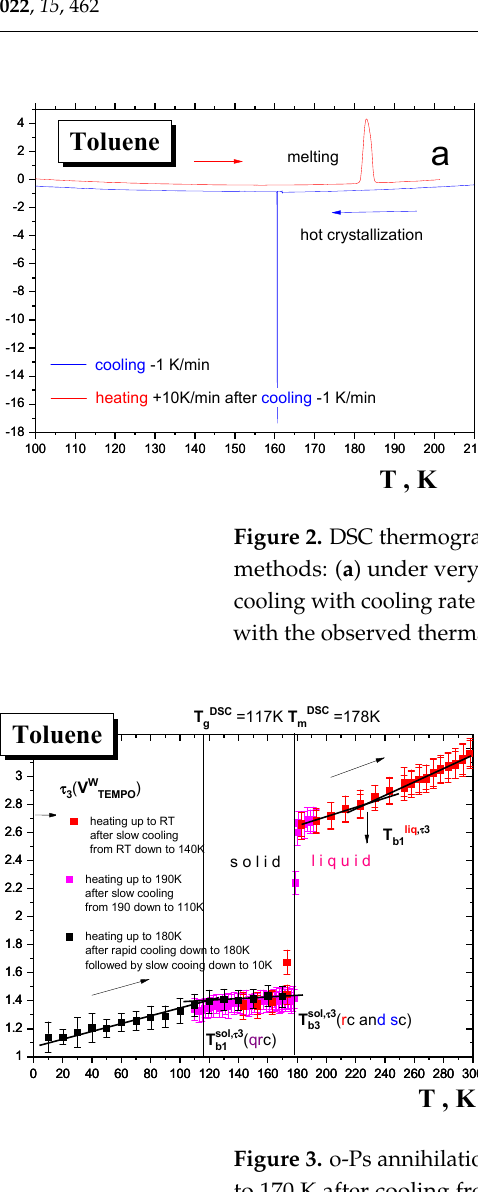
state (red). The characteristic PALS temperatures of various effects are mentioned in the text and the